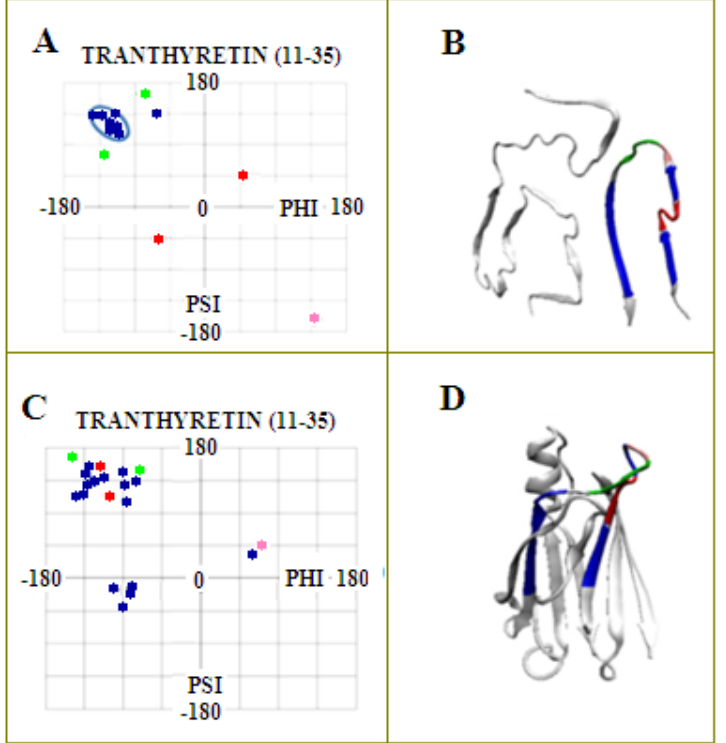
Figure 11. Fragment 11 – 35 in the structure of the amyloid (shown in A , B ). ( A ) — distribution of the Phi and Psi angles present in this fragment. ( B ) — 3D structure with a highlighted (navy blue) section being the object of the analysis, with the sections highlighted in red — the place of disturbance of the rectilinear β -structure. The set of angles fulfilling the condition Psi = − Phi in the native form (shown in C , D ) was distinguished. Two red points ( A ) correspond to the conformation typical for left and right-handed α -helix causing a zigzag — red in Figure B; two green points — proline and adjacent serine; pink point — glycine forming a twist in the upper part of the loop. ( D ) — 3D presentation of the structure of the transthyretin chain in amyloid form with highlighted fragments according to the color scheme in ( C ). A set of navy blue points — a model set of Phi angles in the mutual relation Phi = − Psi creating a rectilinear structure — navy blue fragments in ( B ). Colors consistent with the 3D presentation and the respective Phi and Psi angles.